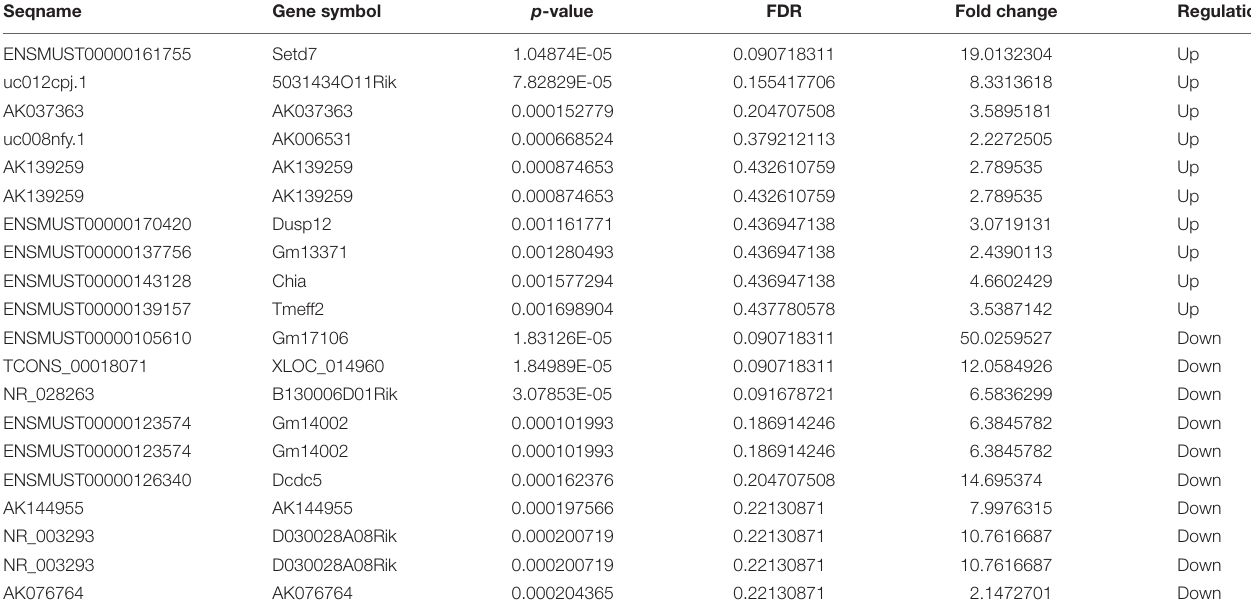
TABLE 3 | Top 10 up- and down-regulated DElncRNAs in the hippocampus of Nrf2 ( − / − ) mice. Seqname Gene